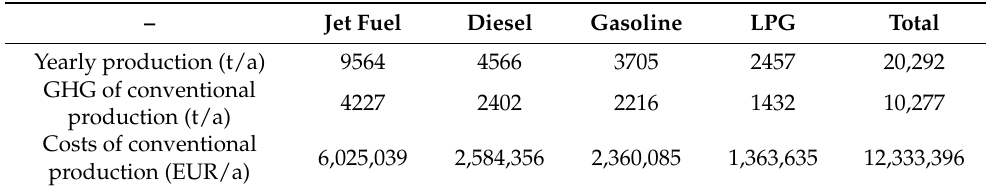
Table 10. Calculated yearly production, greenhouse gas emissions and costs of conventional fuels production.